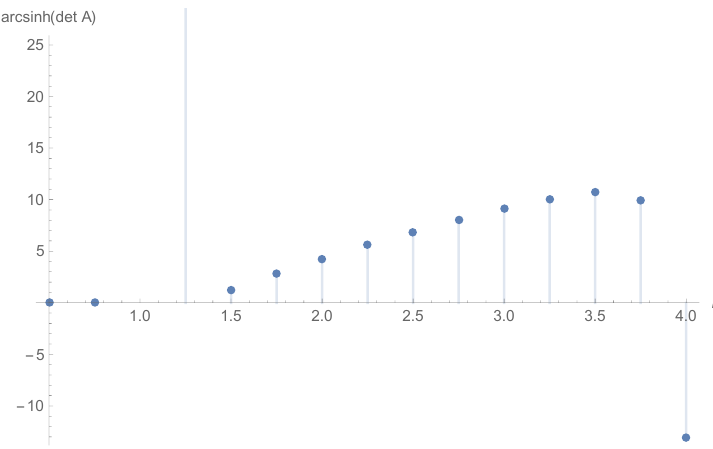
Figure 1 . Behaviour of the determinant (3.47) as a function of (cid:20) for the four-dimensional elliptic solution. For clarity, we actually plot arcsinh(det A ( (cid:20) )) in order to limit the range of values.